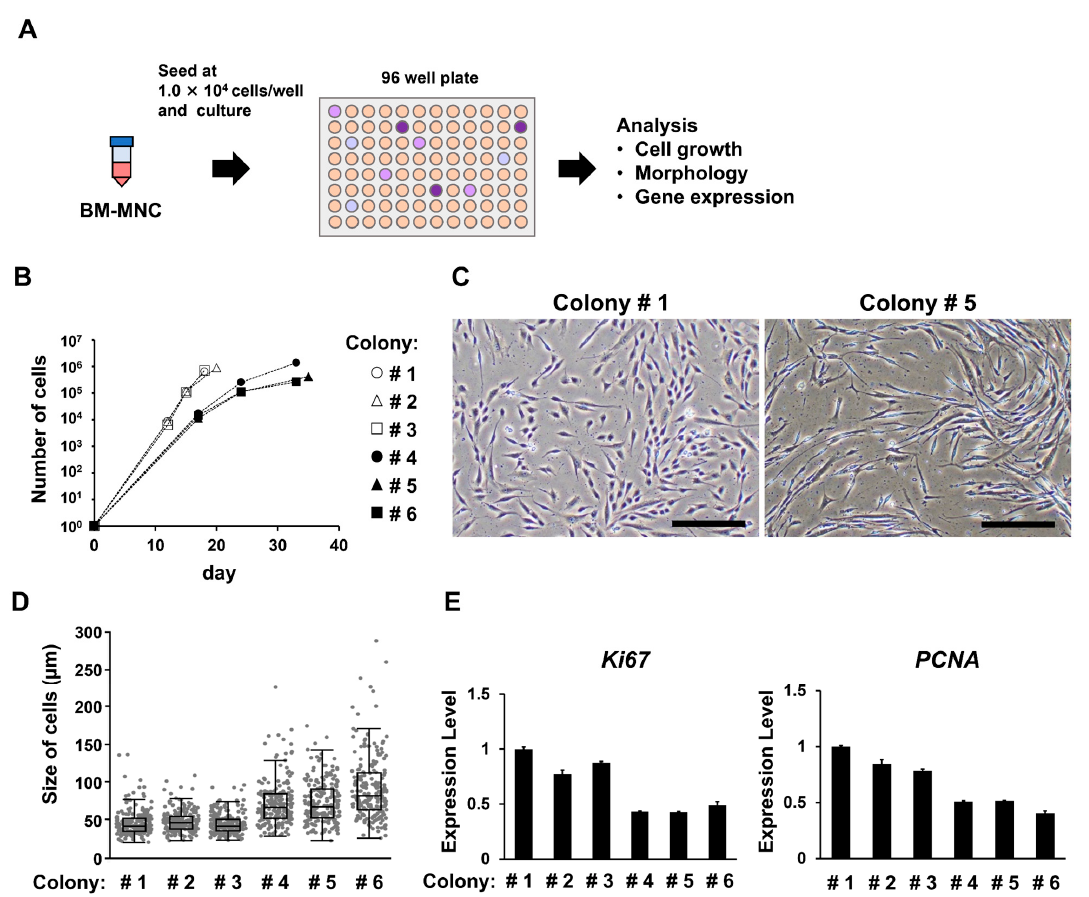
Figure 4. Evaluation of the relationship between the timing of colony formation and the characteris- tics of mesenchymal stem cells (MSCs) after passaging. ( A ) Schematic of the single cell cloning assay. Mononuclear cells (MNCs) were seeded at 1 × 10 4 cells/well to form one colony per well, then passaged. MSCs cultured from each colony were characterized. ( B ) The number of cells harvested. ( C ) Phase-contrast microscope images of cells isolated from colonies formed earlier (colony#1) and later (colony#5). Scale bar indicates 300 µm. ( D ) Boxplot shows cell size data obtained using the microscopic images. ( E ) Data from real-time PCR analysis of Ki67 and PCNA in Passage 3 cells. The error bars indicate S.E. ( n = 3). 3.5. MSCs Isolated under the Low MNC Seeding Density Condition Have Higher Proliferative Ability and Improved Differentiation Potential The low MNC seeding density condition (4.0 × 10 4 –1.25 × 10 5 cells/cm 2 ) was found to increase the purity of MSCs with high proliferative potential, and 5 min trypsin treatment was found to exclude senescent cells (Figure 2D,F). To evaluate this method on the quality of isolated MSCs, we isolated the MSCs at low MNC density (1.25 × 10 5 cells/cm 2 ) and high MNC density (1.25 × 10 6 cells/cm 2 ), which had a clear difference on colony formation. We confirmed that isolated cells in both conditions expressed an MSC-specific marker. In the low MNC density condition, the MSC purity was higher than that in the high MNC den- sity condition (Figure S1). Next, we compared the growth rate, morphology, and gene expression of the cells obtained under each condition. The cells obtained from the low density condition showed a significantly shorter doubling time than those obtained from the high density condition ( p < 0.01, Figure 5A,B). Furthermore, these cells exhibited a